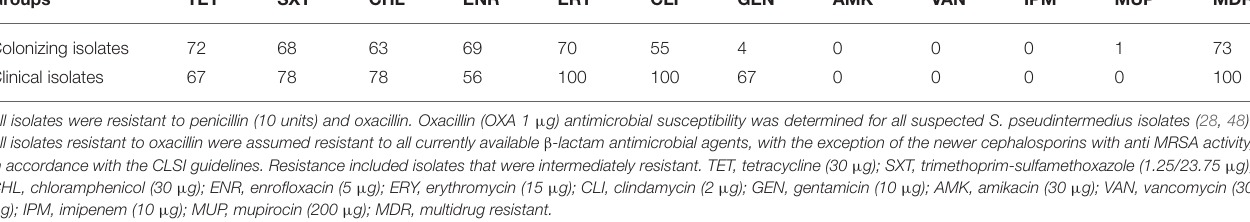
TABLE 1 | The percentage of all methicillin-resistant Staphylococcus pseudintermedius (MRSP) isolates from this study that displayed phenotypic resistance to 11 antimicrobials. Groups Colonizing isolates Clinical